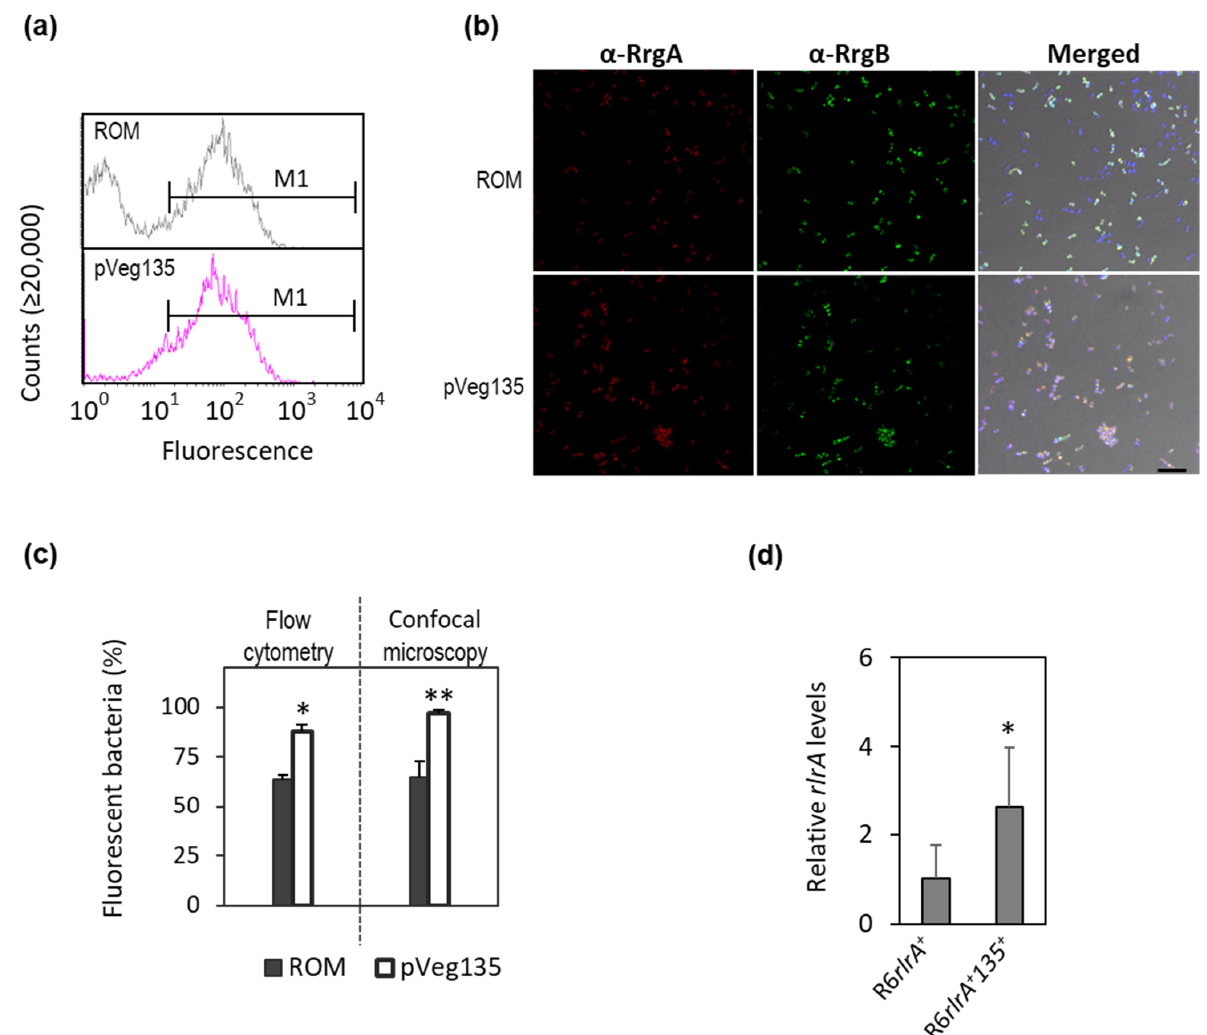
Figure 5. Overexpression of srn135 causes a monophasic pilus expression pattern. The percentage of piliated bacteria in TIGR4(pveg135) ( pveg135 ) and the TIGR4(pROM) control strain ( ROM ) was studied. ( a ) Flow cytometry was used to assess the pilus expression pattern. Bacteria were labeled with anti-RrgB as primary antibody and Alexa Fluor 488 goat as a secondary antibody. Sera of mice immunized with PBS were used as the negative control. A representative histogram of TIGR4(pROM) and TIGR4(pveg135) is shown. M1 denotes counted cells. ( b ) For immunofluorescence, samples were processed as described in Materials and Methods and stained with anti-RrgA ( α -RrgA) and anti-RrgB ( α -RrgB). Imaging was performed with a Leica TCS-SP5-AOBS (Mannheim, Germany) confocal microscope. The right panel represents the merged signal of α -RrgA (red), α -RrgB (green), and DAPI staining (blue). The scale bar is 75 µ m. ( c ) The percentage of piliated bacteria on each strain was determined by flow cytometry (left) and confocal microscopy (right). Data from flow cytometry are the mean of three independent experiments. Data from confocal microscopy are the mean of four independent experiments ( n = 3 fields on each). ( d ) The effect of srn135 on rlrA expression was studied in a non-piliated R6 pneumococcal strain harboring an exogenous rlrA gene inserted in the bgA locus ( R6rlrA ). Transcript levels were determined by qRT-PCR in the R6rlrA containing the pveg135 plasmid ( R6rlrA + 135 ) or the empty pROM vector ( R6rlrA ). Data represent transcript